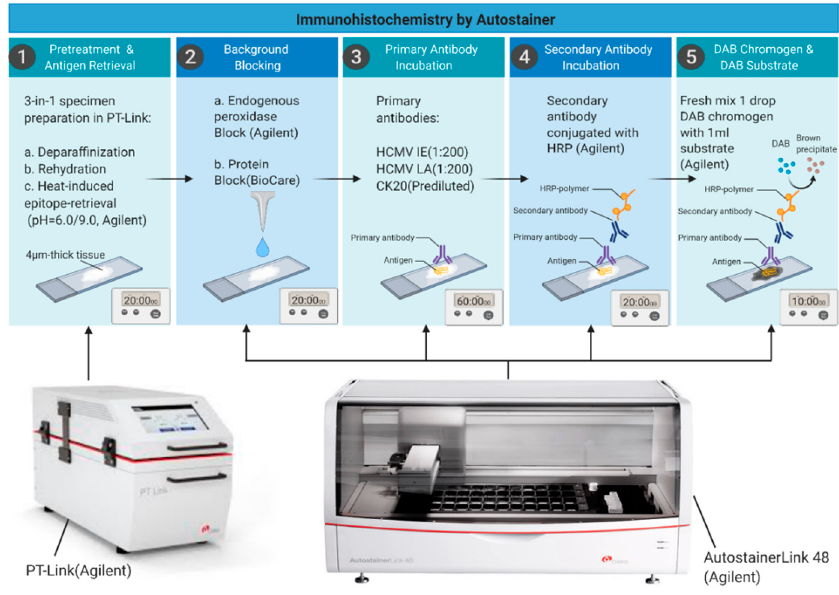
Figure 2. Schematic presentation of the automated IHC process. Created with BioRender.com (accessed on 5 April 2021).